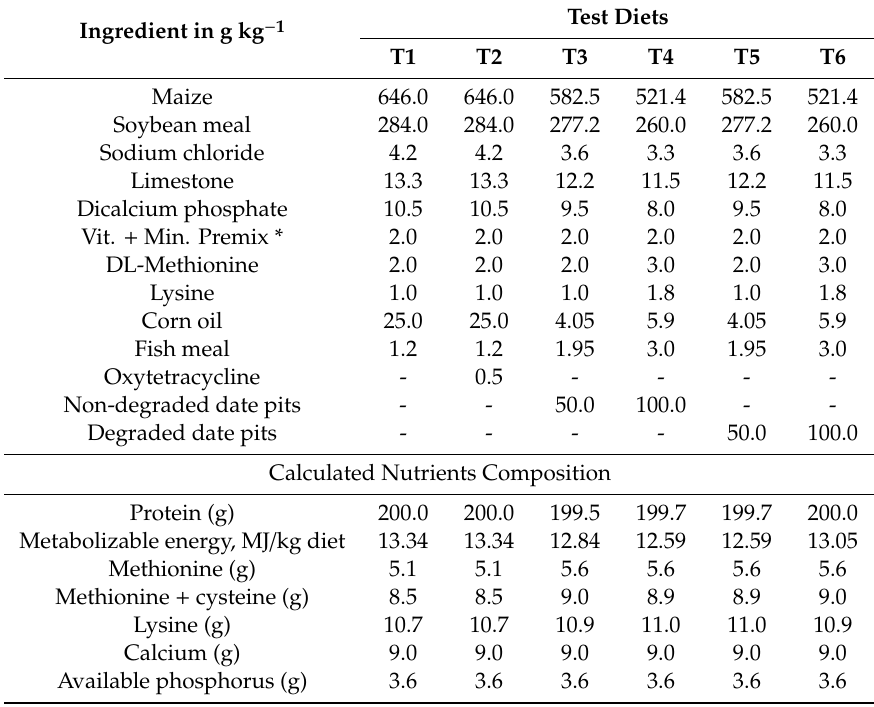
Table 2. The composition of the six experimental finisher test diets and their calculated nutrients composition (finisher period from day 21 to day